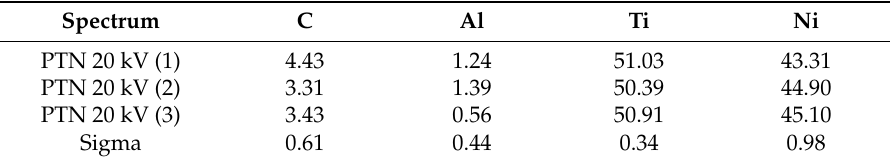
Table 6. Mean atomic weight percent (%) of M-Wire alloy PTN endodontic rotary files at 15 kV and 20 kV and three different locations (1, 2, and 3).